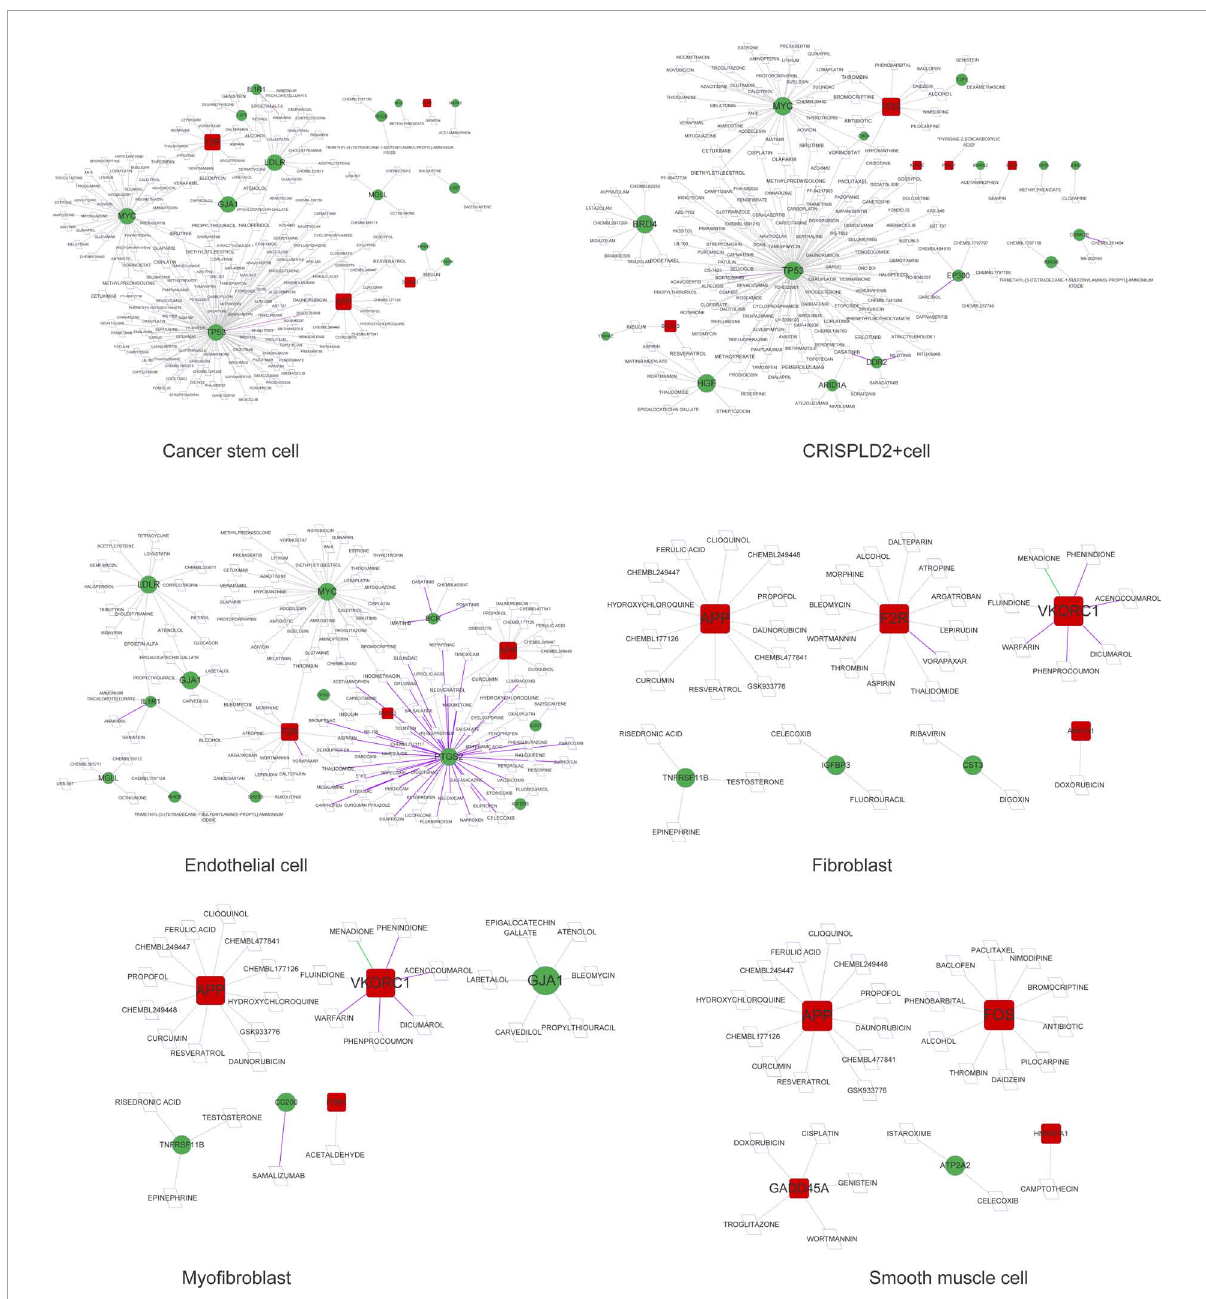
FIGURE6 The drug–gene network in cancer stem cells, CRISPLD2 + cells, endothelial cells, fibroblasts, myofibroblasts, and smooth muscle cells. Red squares represent upregulated mRNAs; green circles represent downregulated mRNAs; purple lines represent the drug as an antagonist or inhibitor; green lines represent the drug as a promoter or adjuvant; gray lines represent an unknown effect.